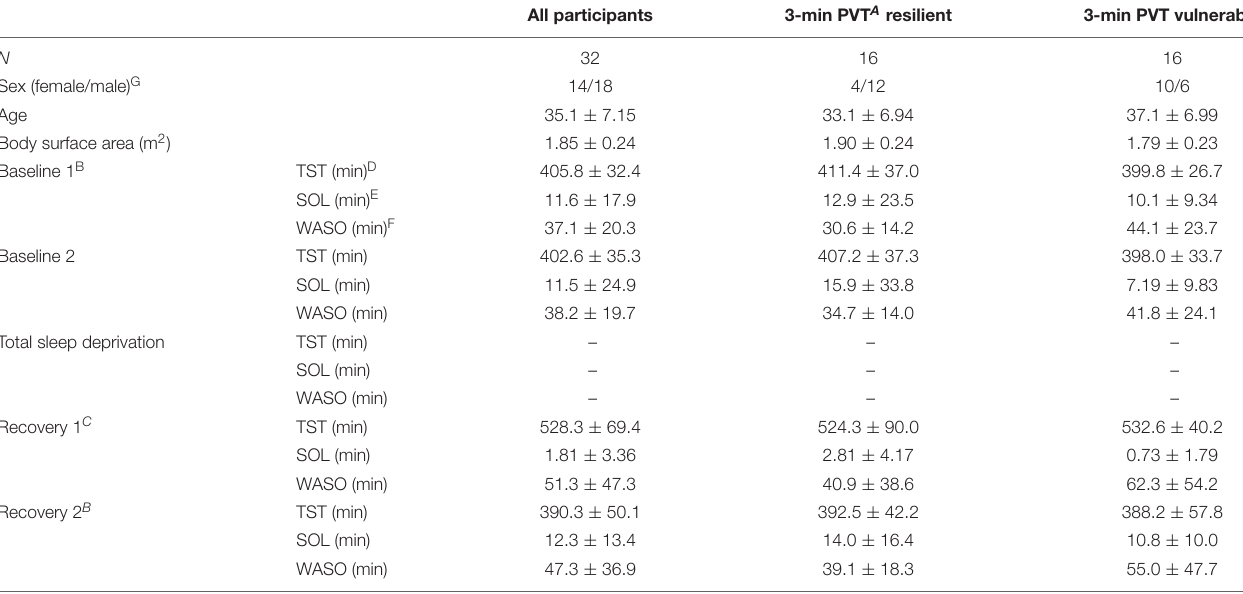
TABLE 1 | Participant characteristics and actigraphic sleep data during the 5-day experiment (mean ± SD).